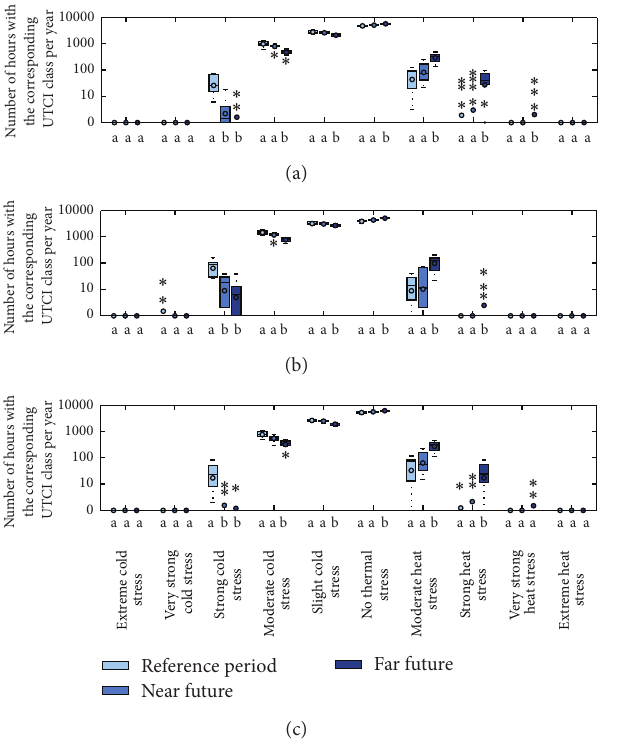
Figure 7: Boxplots of UTCI values for the three periods: reference period 1991–2000, near future 2041–2050, and far future 2091– 2100 at the three pseudo stations Esch-sur-Alzette (a), Reuler (b), and Wasserbillig (c). Boxplots show the number of hours within the corresponding UTCI class per year. The whisker length is determined by 1.5 ∗ interquartile range (IQR). All values larger than 1.5 ∗ IQR are treated as outliers. Median values are indicated by the line inside the box, mean values by the dot. Groups that are sharing the same letters are not significantly different ( 𝑃 < 0.05 ).